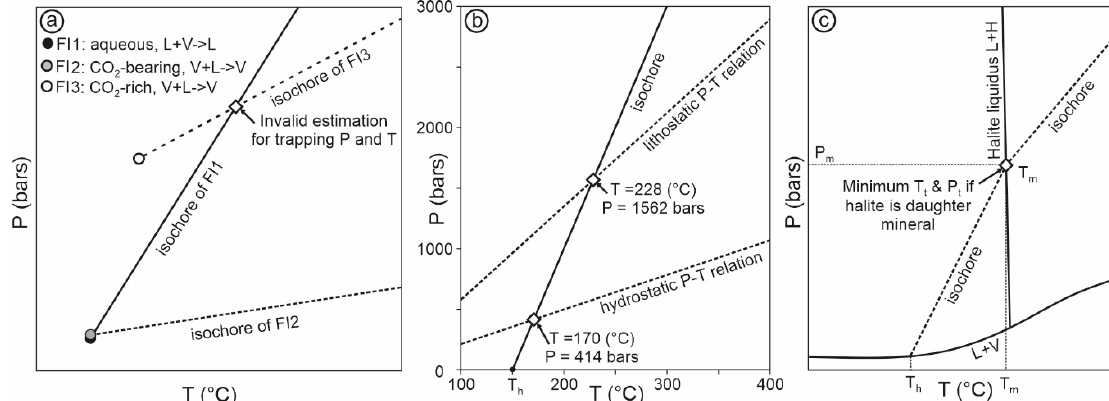
Figure 7. ( a ) Schematic diagram showing isochores of an aqueous inclusion (homogenized to liquid; FI1), a CO 2 -bearing inclusion (homogenized to vapor; FI2), and a CO 2 -rich inclusion (homogenized to vapor; FI3). Note if FI1 and FI2 are interpreted to represent immiscible fluid phases entrapped at the same time, then their homogenization temperature and pressure represent the T t and P t ; FI1 and FI3 cannot be entrapped at the same time unless they can be proven to be physically separated, and their intersection cannot be used to indicating the T t and P t . ( b ) Isochore for a fluid inclusion with a T h of 150 °C and salinity of 10 wt% NaCl (calculated with the program of Steele-MacInnis et al., 2012 [50]) and its intersections with P–T relations for a geothermal gradient of 35 °C/km for lithostatic and hydrostatic pressure regimes; note the large difference in estimated T t and P t for the two different pressure regimes. ( c ) Schematic diagram showing part of the phase relationships of the H 2 O–NaCl system including the liquid–vapor curve and the halite liquidus and the isochore of a fluid inclusion, whose halite dissolution temperature ( T m ) is higher than vapor disappearance temperature ( T h ) (modified from [46]); note that if the halite cannot be proven to be daughter mineral, then the T s and corresponding pressure ( P m ) do not represent the minimum T t and P t .